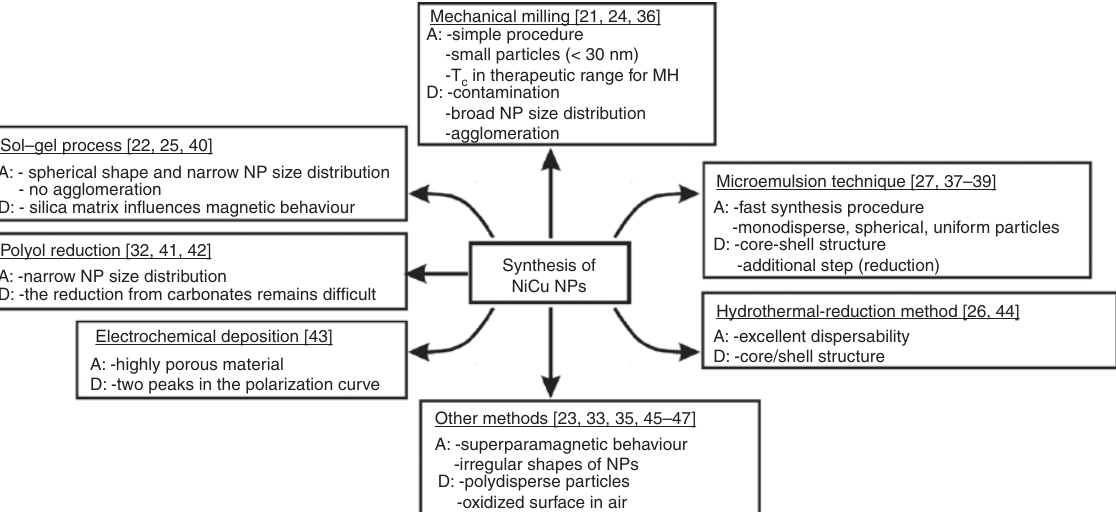
Figure 3: Comparison of the different NiCu MNPs preparation procedures. A → advantages, D → disadvantages, and MH means magnetic